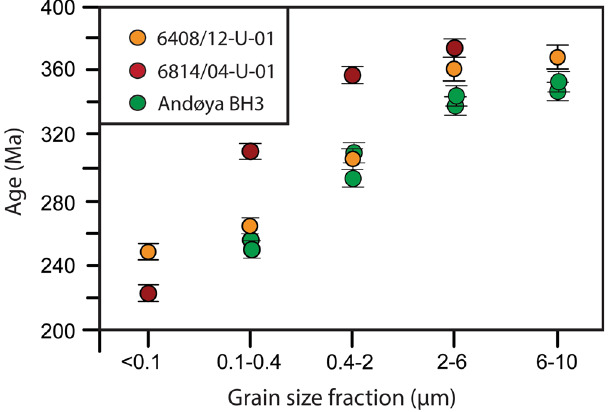
Fig. 5 K-Ar geochronology of weathered basement. K-Ar ages (Ma) versus grain size ( µ m) for the analysed samples from the highly weathered basement of offshore wells 6408/12-U-01 and 6814/04-U-01, as well as Andøya borehole BH3 onshore. K-Ar age errors (bars) are within 1 σ uncertainties (see Table